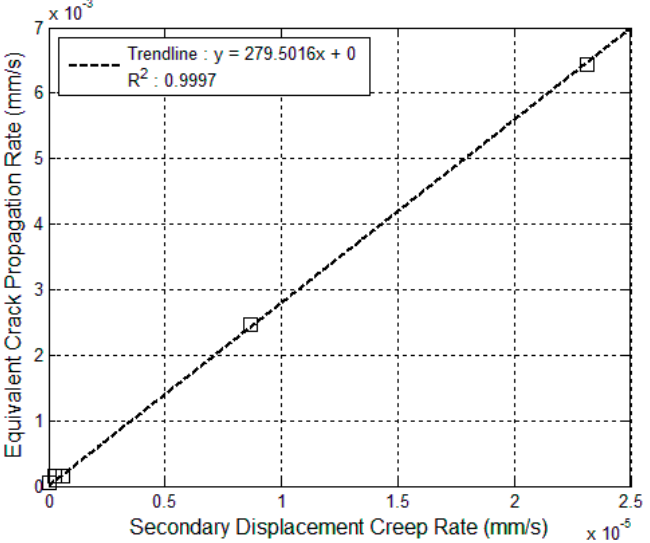
Figure 7. Equivalent crack propagation rate versus secondary displacement (D25) creep rate curve.